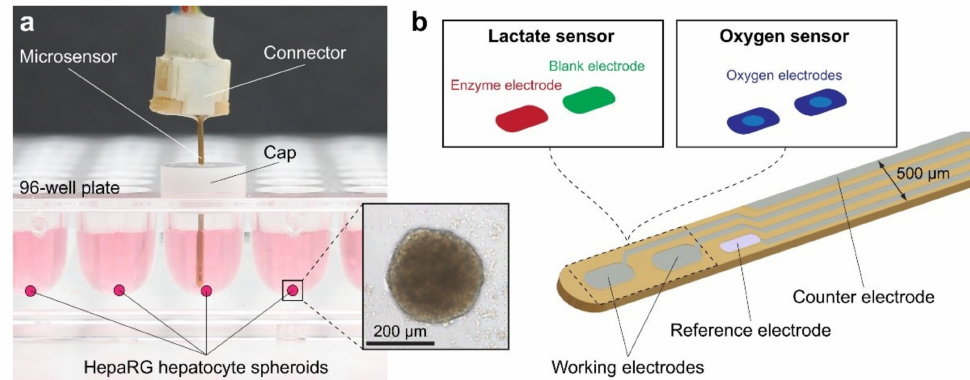
Figure 6. Lactate and oxygen sensors are used to better understand the impact of drugs, reproduced with permission from Ref. [144]. ( a ) The image shows a 96-well cell culture plate holding the microsensor device. ( b ) The graphic shows a magnified version of the tip of the microsensor as well as the electrode layout. Different electrodes are also seen in the graphic such as working and counter. To eliminate unspecific background, the set up uses working electrodes with stationary lactate oxidase and a blank electrode. The oxygen sensor uses the same setup and two working electrodes, which include a limiting diffusion